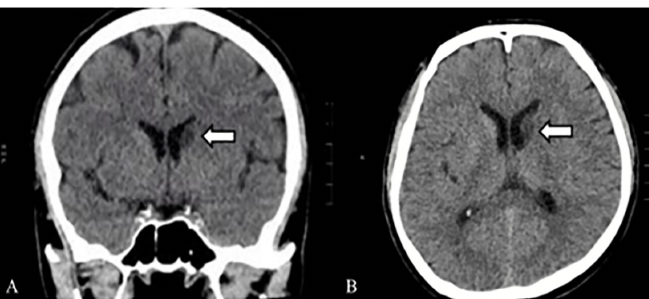
Image 2. Coronal images of a brain computed tomography without contrast of a 58-year-old male presenting with a headache, hand numbness, and phantosmia showing a hypodensity in the left caudate nucleus in the (A) coronal (arrow) and (B) axial (arrow)